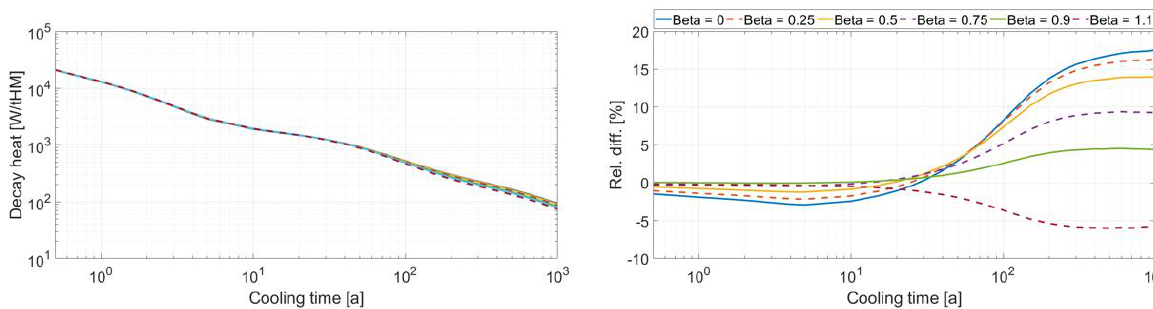
Figure 3. Decay heat rate as a function of cooling time for different albedo boundary conditions.